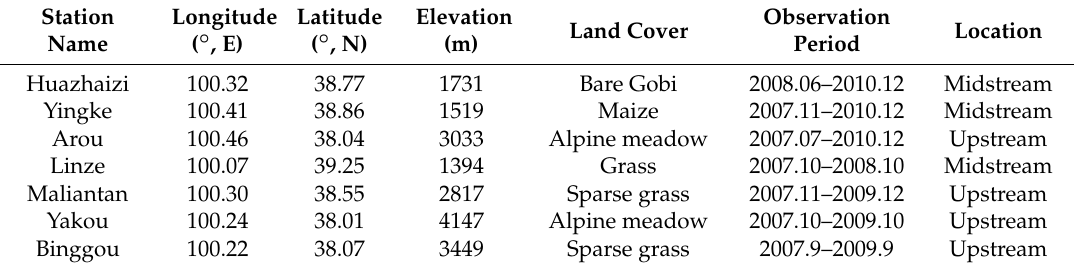
Table 1. Field observation station information for the Heihe River